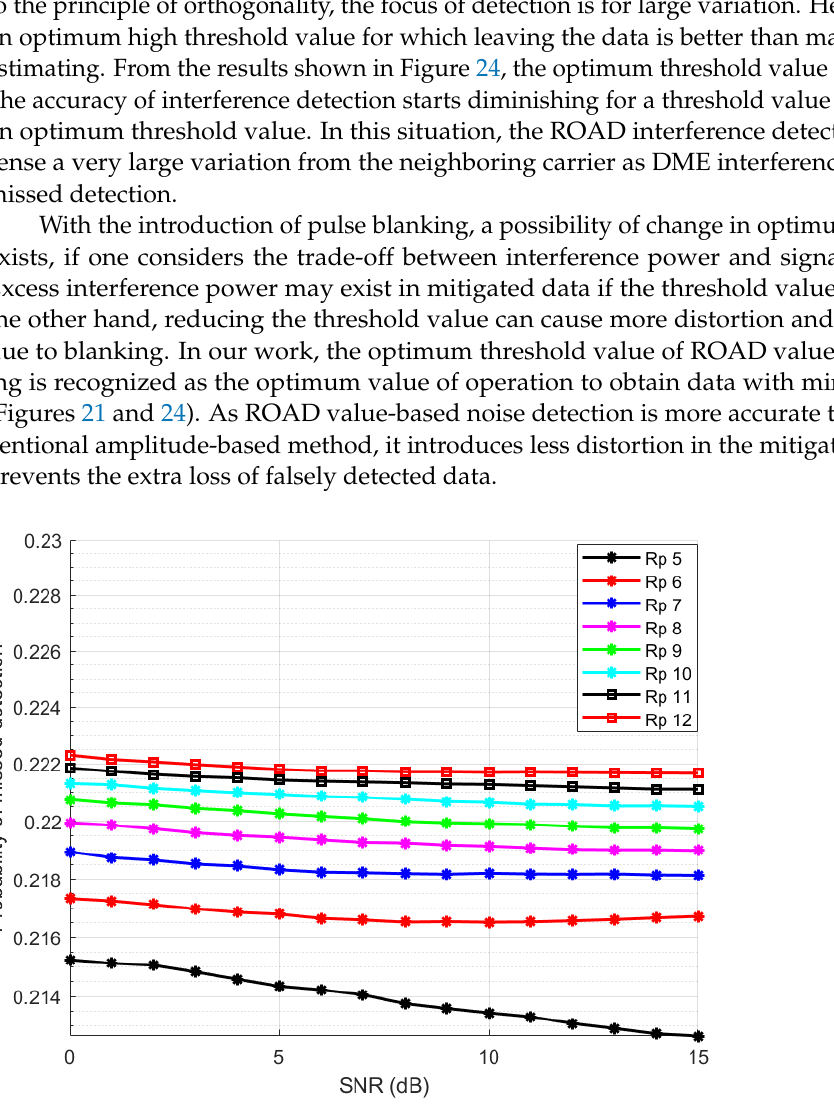
Figure 18. Probability of missed detection in ROAD statistics-based detection for different threshold value vs.